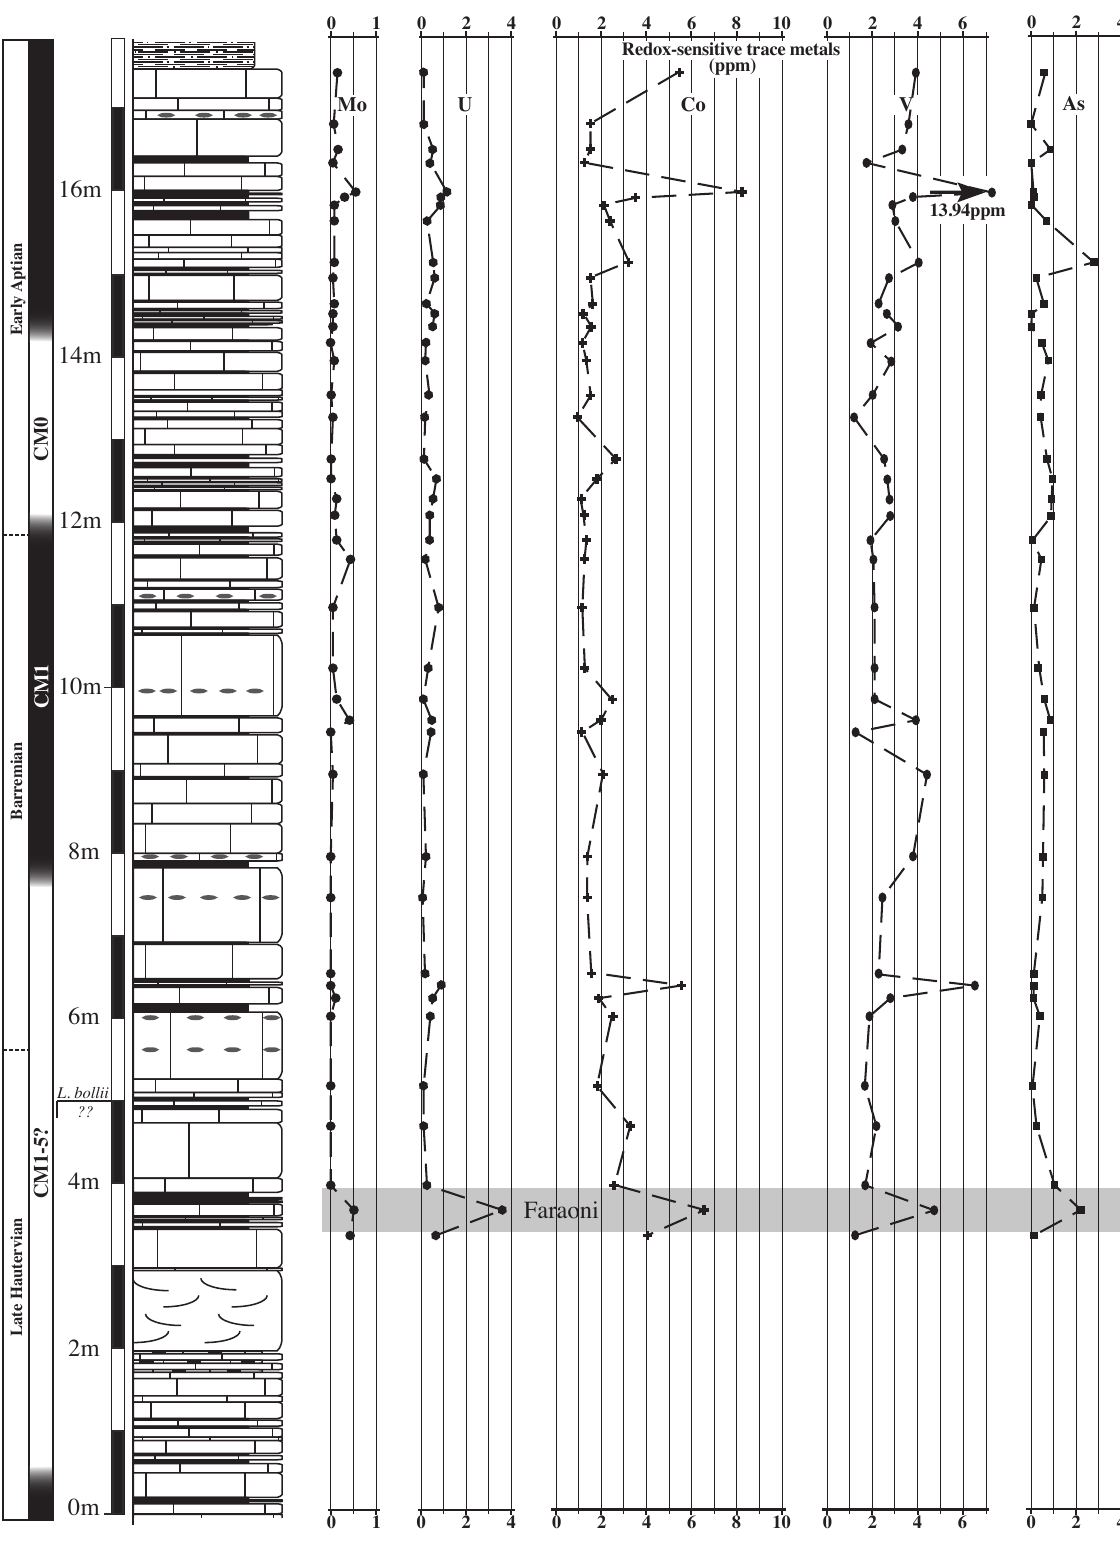
Föllmi et al., Fig. 8 Fig. 8. The Capriolo section: redox-sensitive trace-metal distributions for molybdenum (Mo), uranium (U), cobalt (Co), vanadium (V) and arsenic (As) in carbonate